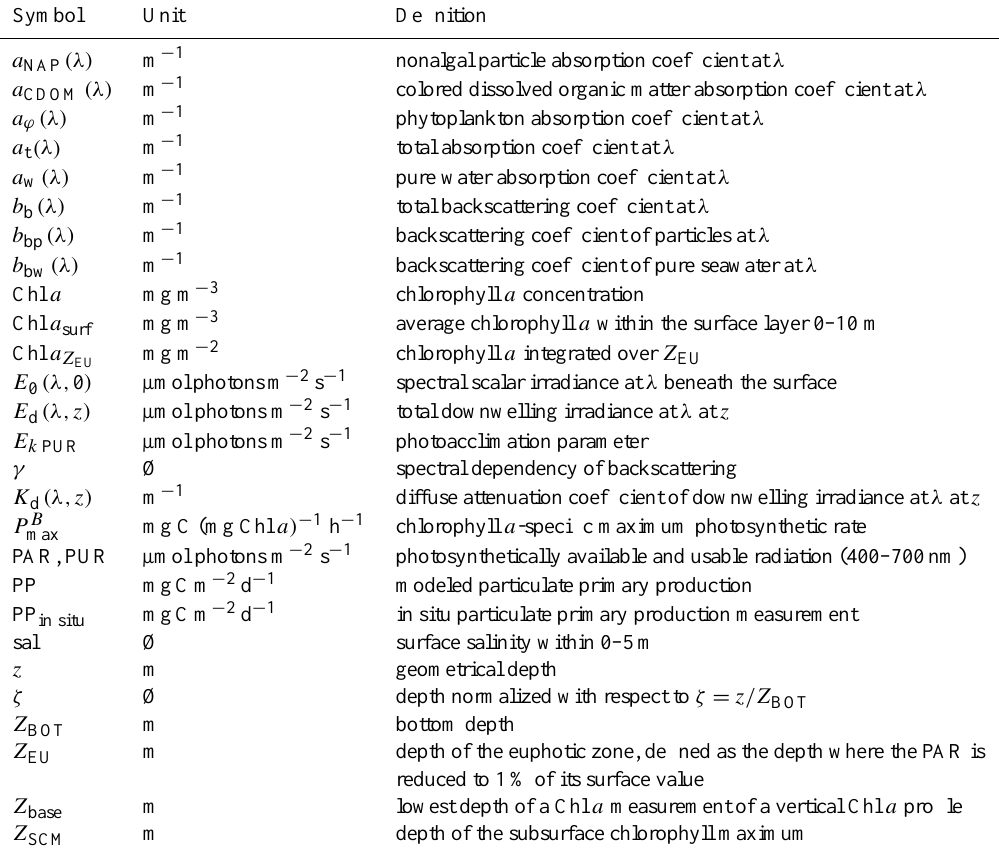
face Chl a concentration C b over which a Gaussian curve is superimposed. The parameters of the Gaussian curve are the normalized maximum Chl a concentration given by C max , occurring at the depth Z max , and having a thickness